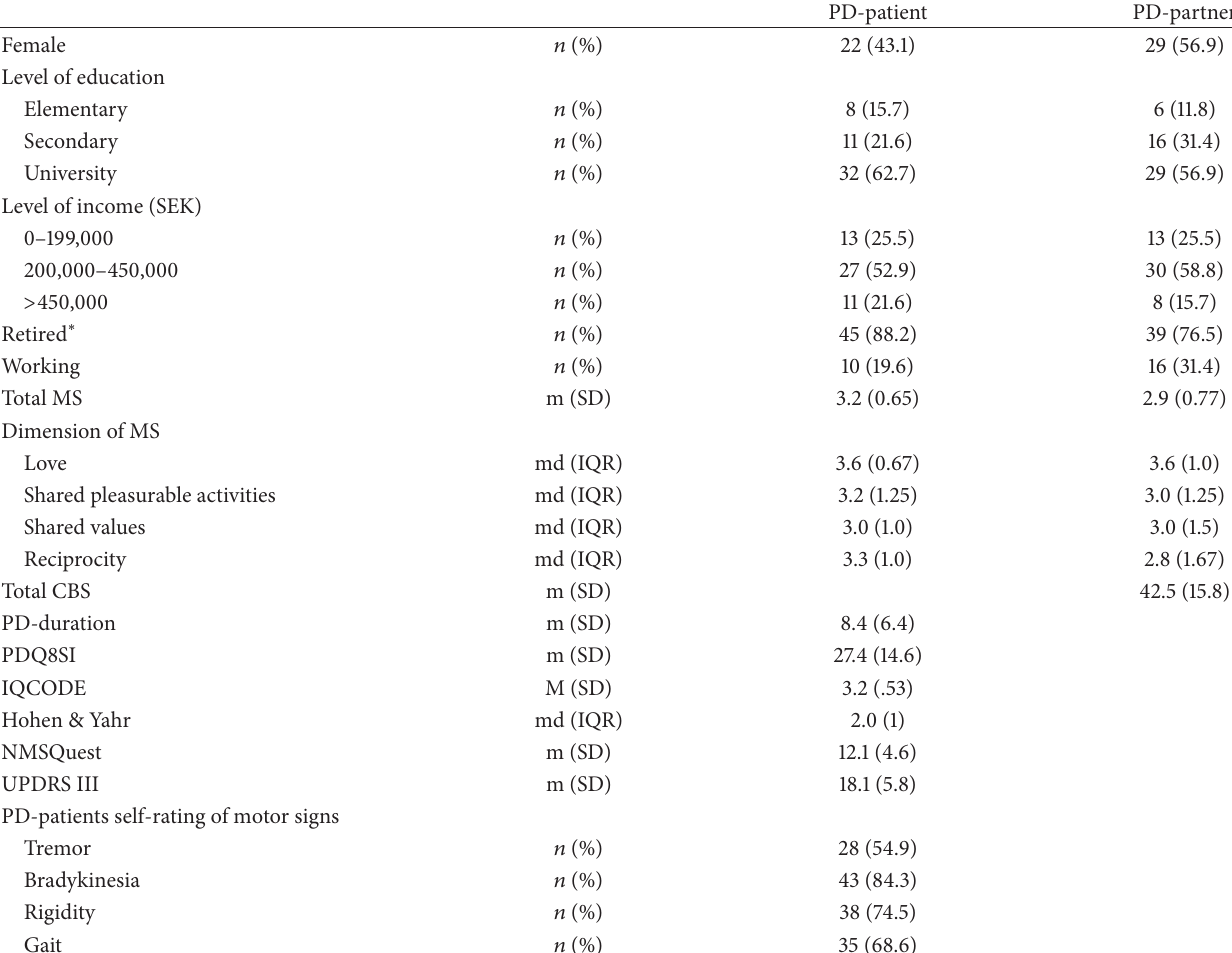
Table 1: Demographics and clinical features. 𝑛 = 51